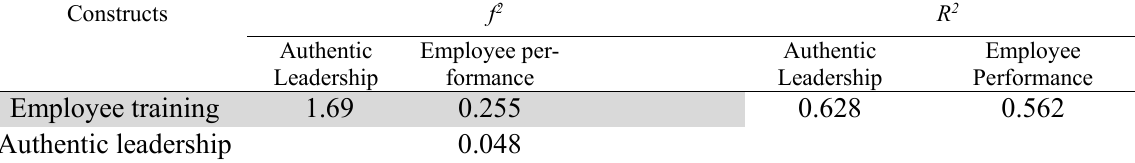
The results of R-square and effect